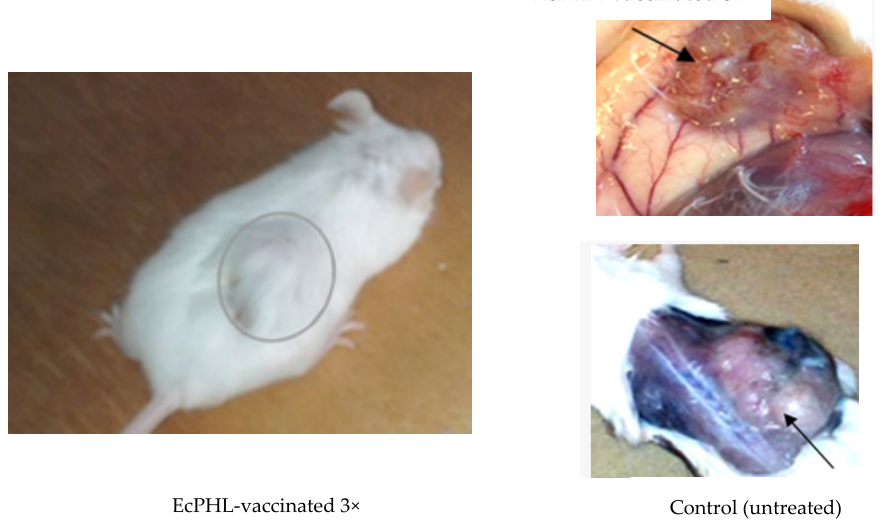
Figure 2. EcPHL-treated and control (untreated) mice and their corresponding tissues.